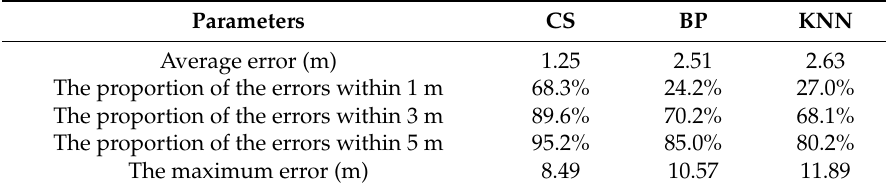
Figure 16. Relationship between localization error and the number of measurements m for OMP, CoSaMP, SP, and GOMP. Table 2. Localization results for different pattern recognition algorithm.